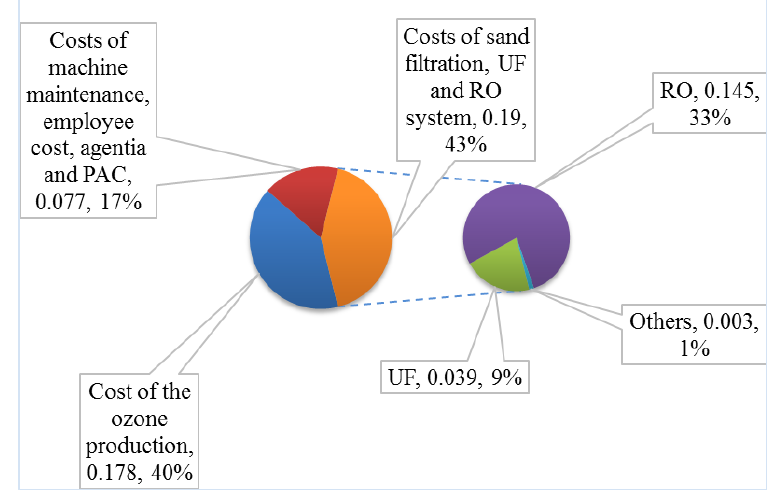
Figure 12. Cost breakdown analysis of water reuse treatment .